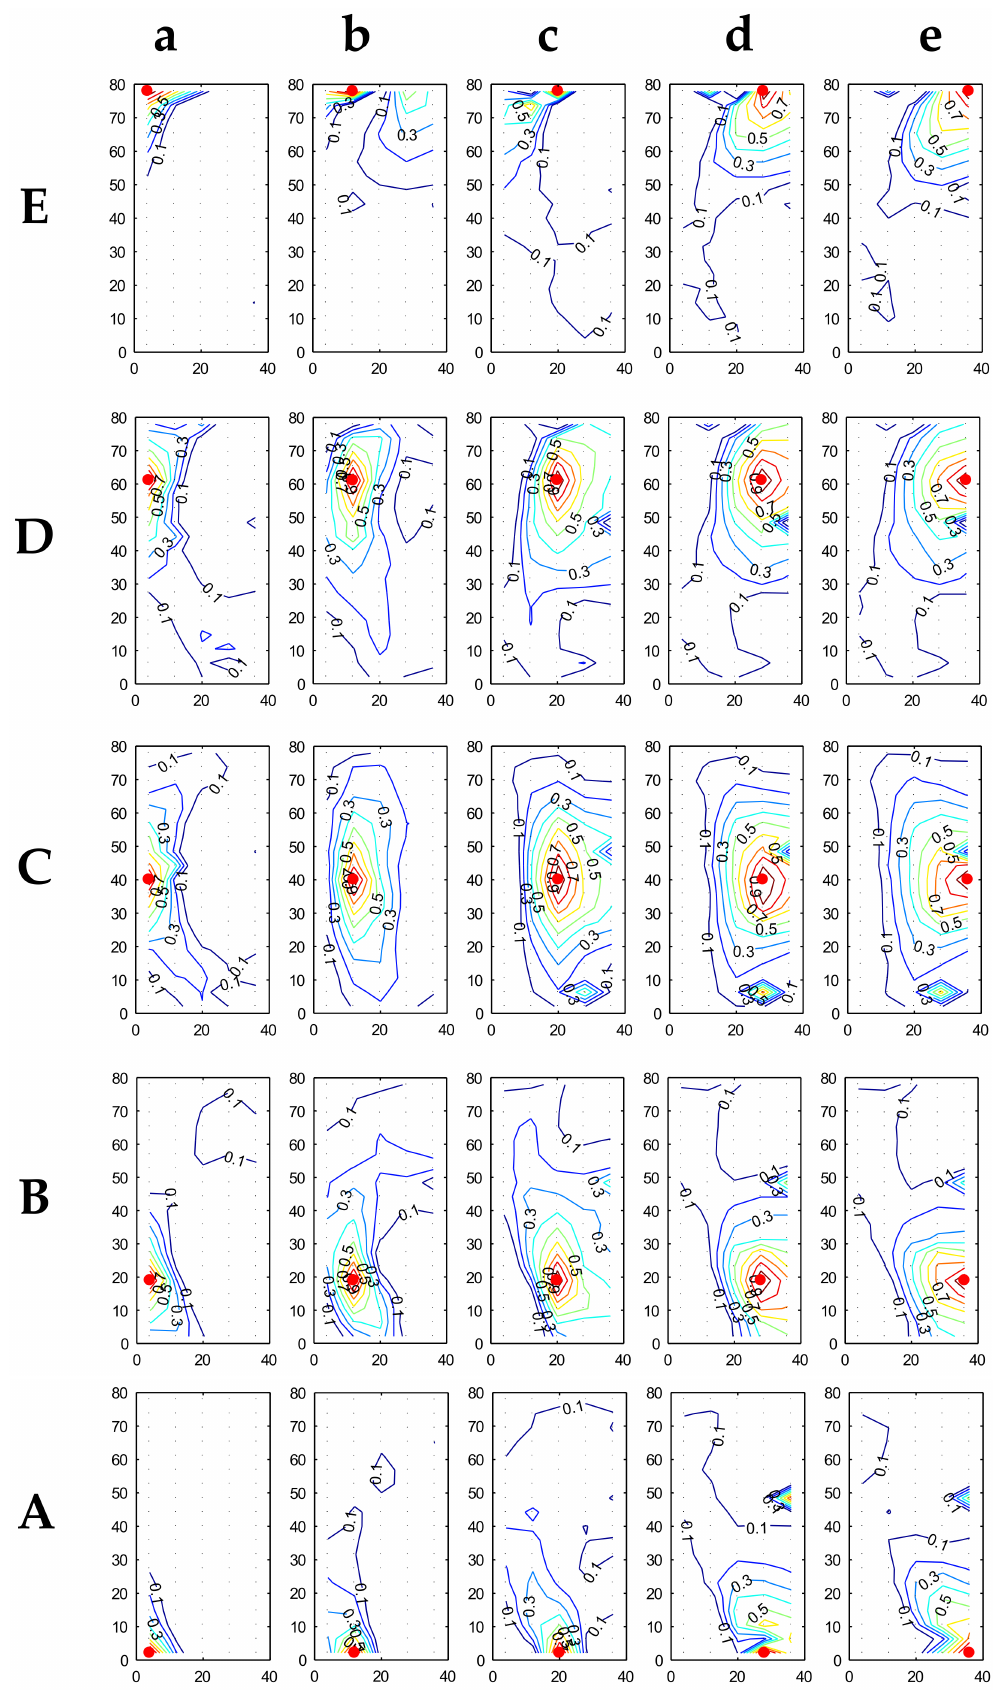
Figure 15. Correlation coefficient trend for RHC at 90 ◦ . Color bar as in Figure